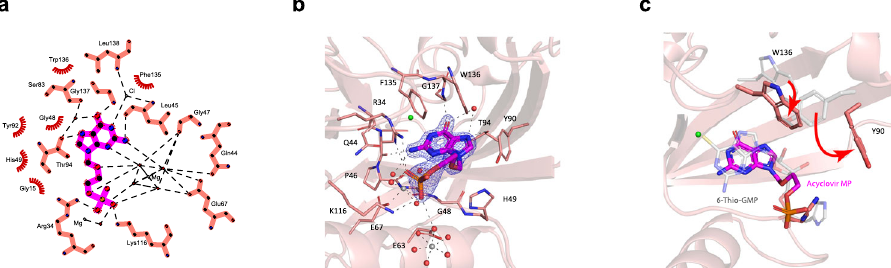
Fig. 2 Structural analysis of NUDT15 interaction with acyclovir monophosphate (ACV-MP). a Ligplot + representation of the binding of ACV-MP with wild-type NUDT15 protein. ACV-MP is shown in magenta and the ACV-MP interacting residues are shown in salmon red. Hydrophobic interactions are shown as arcs with spokes and hydrogen bonds are shown as dashed lines (Laskowski R et al., 2011 71 ). b Three-dimensional view of the ACV-MP interactions with NUDT15. ACV-MP is shown in magenta and the interacting protein residues are shown in salmon red. Magnesium ions are shown in gray and the chloride ion in green. 2Fo − Fc electron density map around ACV-MP is shown as a blue mesh. c Comparison of the ACV-MP structure with the thioguanosine monophosphate (TGMP) bound structure (PDB ID 5LPG). The aligned TGMP bound NUDT15 structure is shown in transparent gray. Residues, which undergo a signi fi cant conformational change between the two structures, are